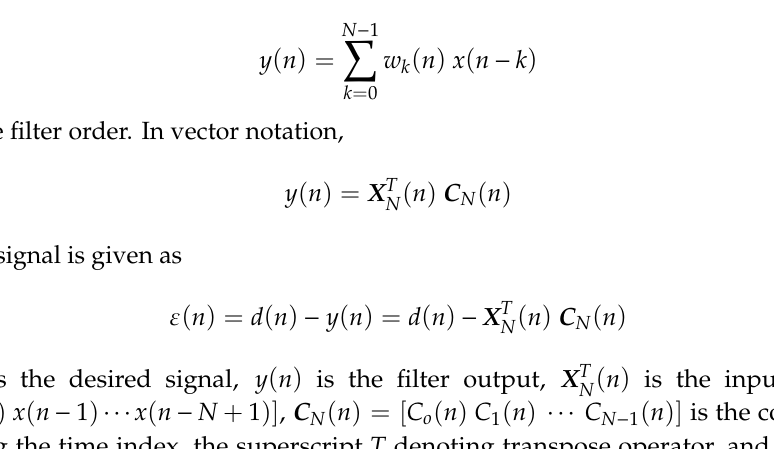
Figure 1. Adaptive finite impulse response (FIR) filter implemented as transversal filter [1].